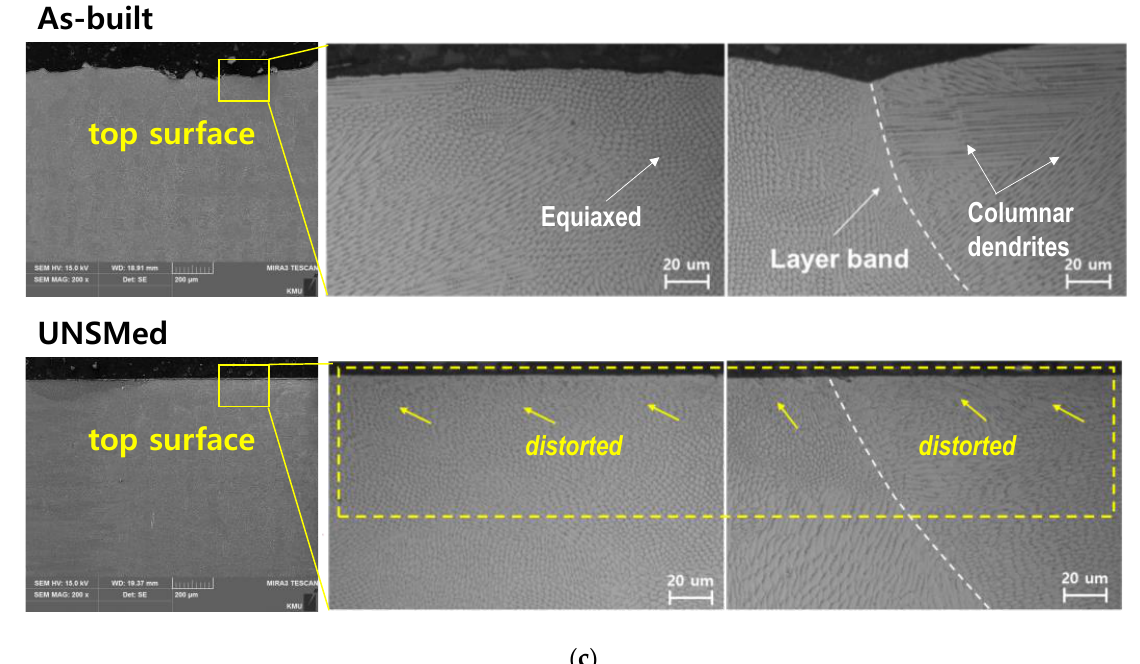
Figure 4. ( a ) Fabricated samples and SEM images of as-built and UNSMed specimens, ( b ) schematic of modification of as-built surface, and ( c ) SEM images of cross-sections of top surface.